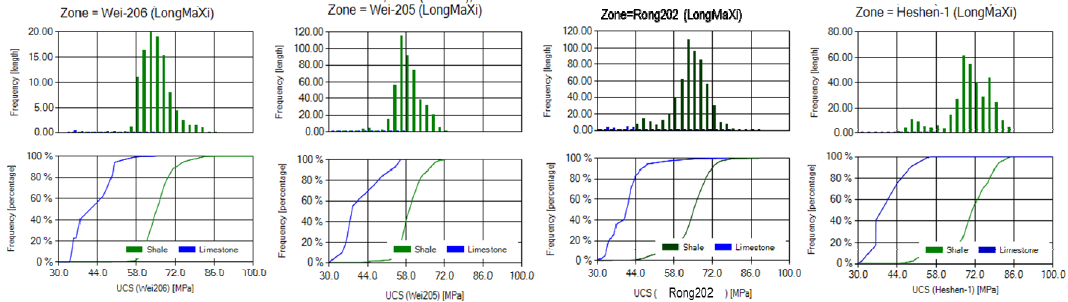
Figure 9. Rock strength comparison in Longmaxi Formation.